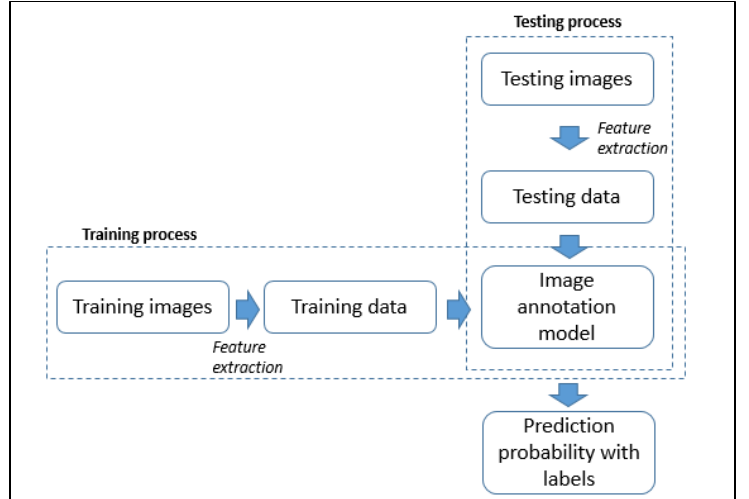
Figure 1. The process of image annotation algorithm.